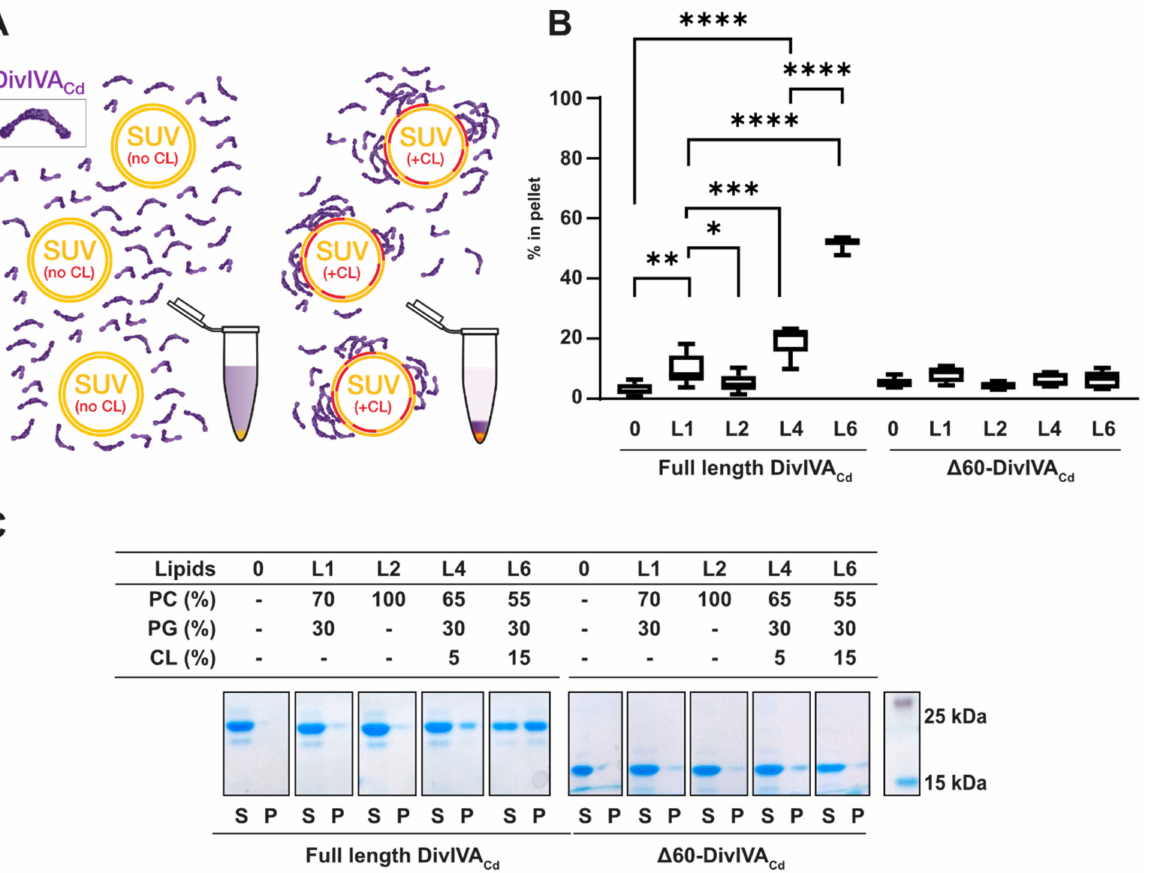
Figure 1. DivIVA Cd binds better to SUVs containing CL and the N-terminal domain is essential for its binding. ( A ) A scheme of the sedimentation assay. DivIVA Cd was mixed with solutions of SUVs that did not contain cardiolipin (in yellow) or contained SUVs with different cardiolipin concentrations (CL is in red). All SUV mixtures were prepared with the buffer containing 30% sucrose to enhance their sedimentation. The SUVs were pelleted by centrifugation and DivIVA Cd amounts were quantified. The DivIVA Cd illustration is based on the structure of the full-length DivIVA Bs tetramer [38]. The sedimentation assay with N-terminally truncated ∆ 60-DivIVA Cd was performed similarly. ( B ) Box and whisker plots of the percentages of DivIVA Cd identified in the pellets under each of the tested conditions. Sedimentation assays were usually performed in triplets and in 3 independent experiments with full-length DivIVA Cd samples. Sedimentation assays with ∆ 60-DivIVA Cd were performed in triplets two times. Selected significant p -values from two-tailed unpaired t -tests are depicted above the plot; the threshold for statistical significance was taken to be p < 0.05. Stars indicate significantly different values, where * corresponds to p -value ≤ 0.05, ** to p ≤ 0.01, *** to p ≤ 0.001 and **** to p ≤ 0.0001. All p -values and percentages of DivIVA Cd or ∆ 60-DivIVA Cd in supernatants and pellets are listed in Tables S4–S6. ( C ) An SDS-PAGE analysis of a representative sedimentation assay. The compositions of the individual SUVs tested are given above the gel. S refers to the soluble fraction; P, to the